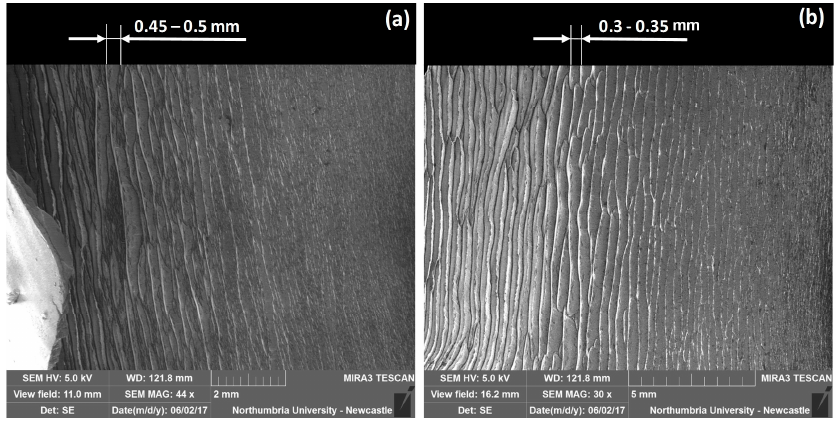
Figure 16. Effect of cutting speed on chip morphology of the free surface: ( a ) 95 m/min; and ( b ) 200 m/min (Cut-list).